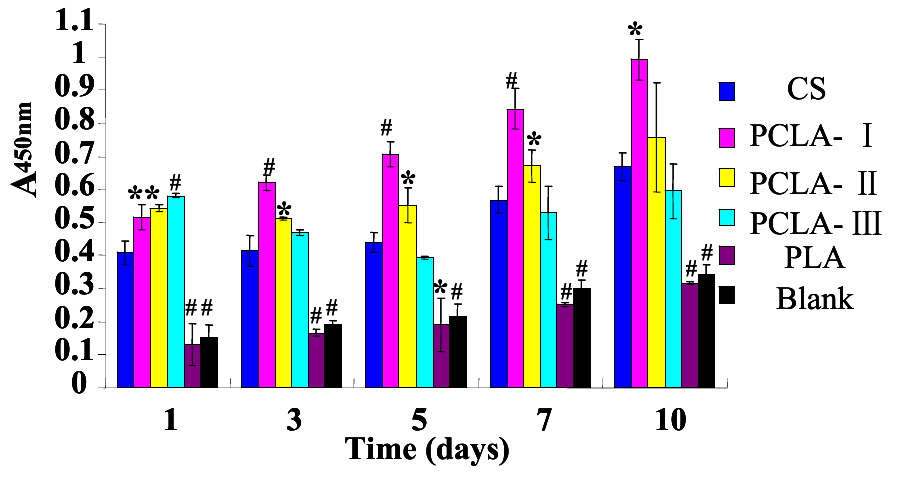
Figure 6. The growth of BMSCs on materials for 1, 3, 5, 7, 10 days cultivation, viability was determined by the MTT assay and analysis by the one-way ANOVA (mean ± SD, n = 3; * p ≤ 0.05 compared with CS and # p ≤ 0.01 compared with